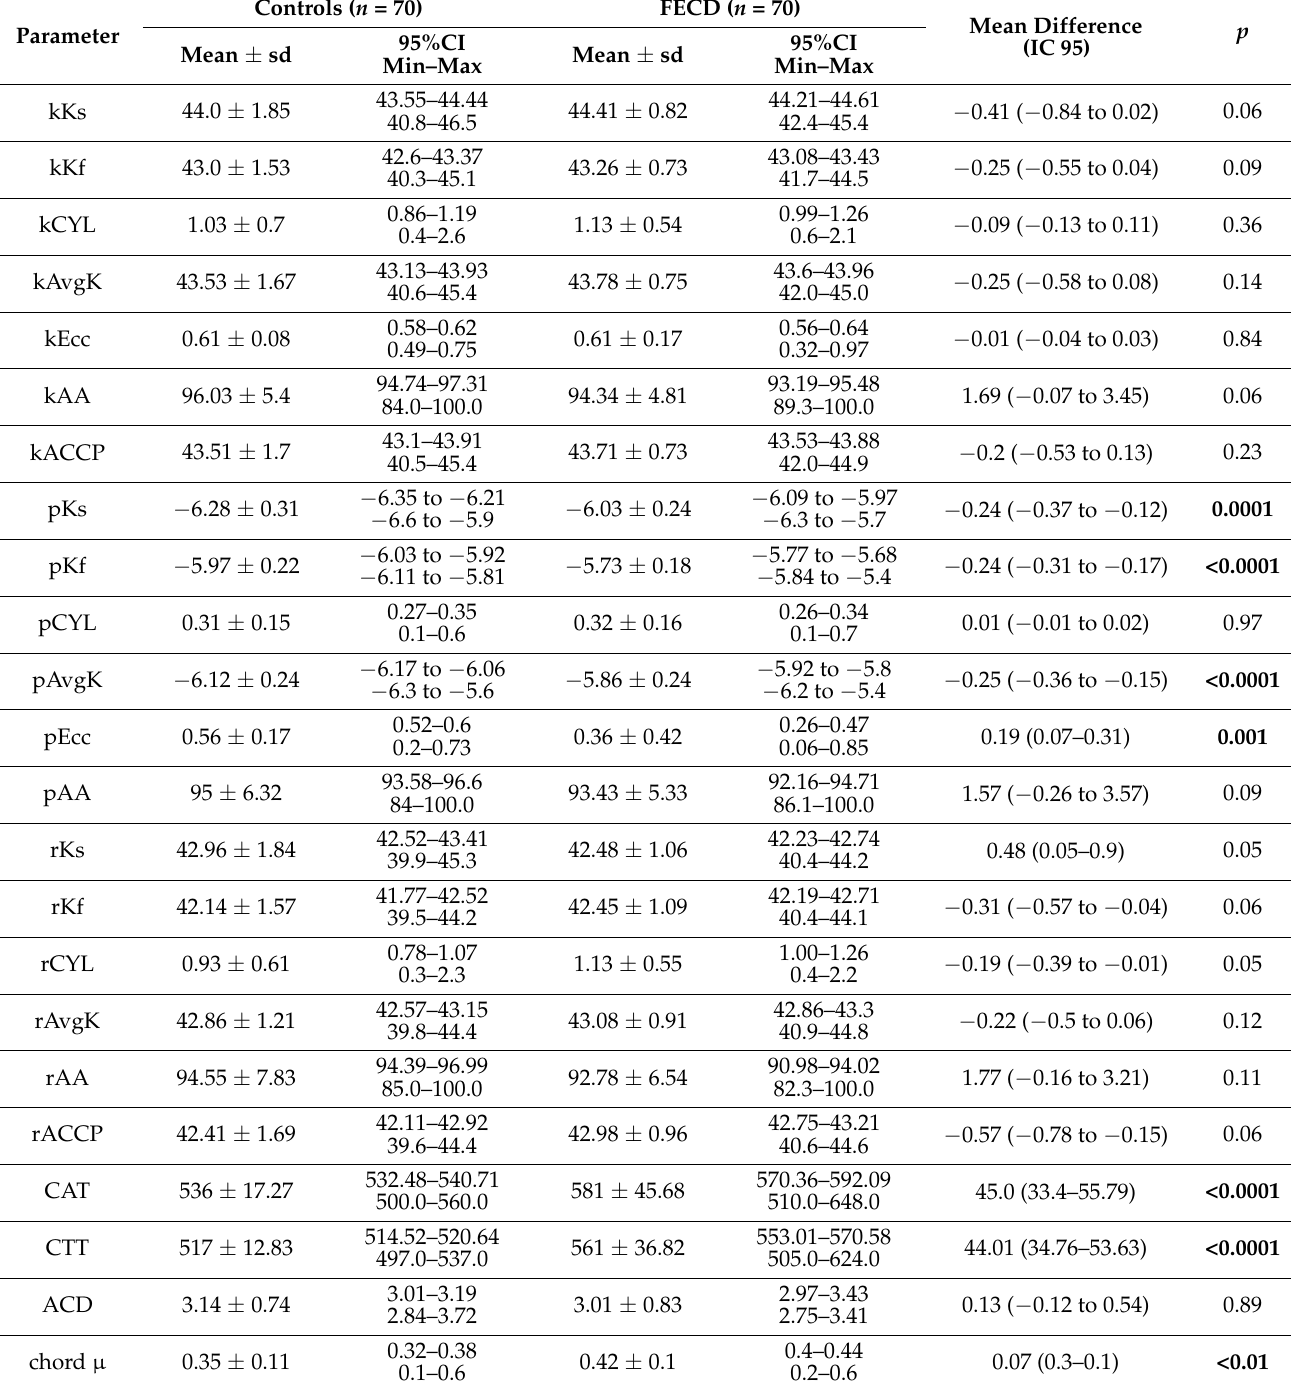
Table 2. Comparison of keratometry, pachymetry, and anterior chamber data of the Fuchs endothelial corneal dystrophy (FECD) eyes and control